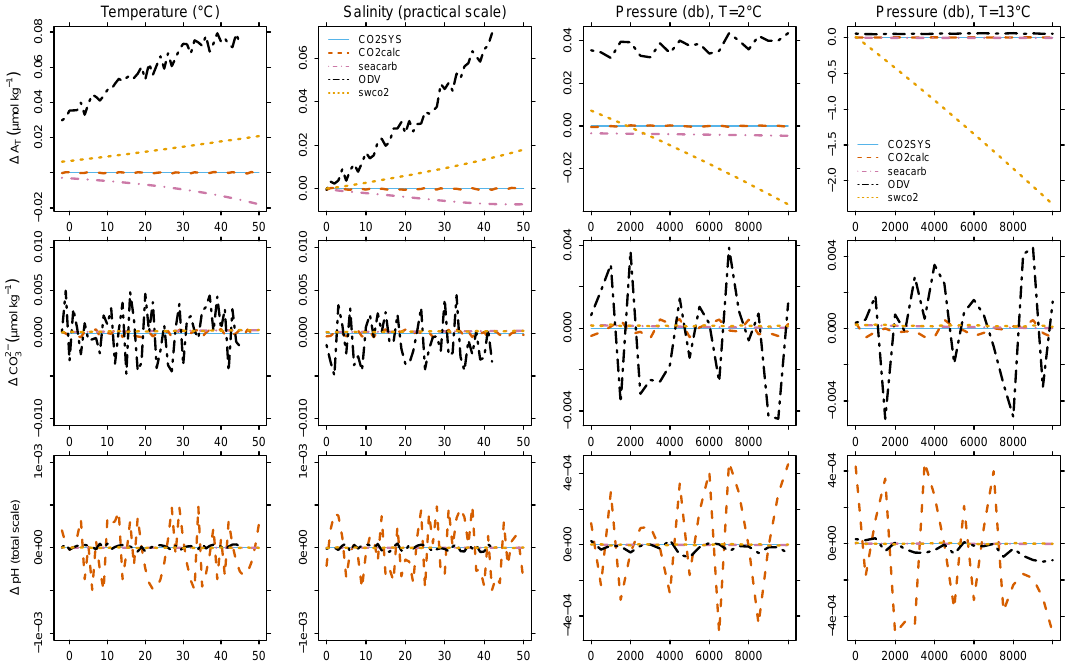
Figure 9. Variables computed from C T and p CO 2 with each package minus corresponding results from CO2SYS-MATLAB. Shown are computed A T (top), CO 2 − (middle), and pH (bottom) across ranges of T (column 1), S (column 2), and P when T = 2 ◦ C (column 3) and 3 when T = 13 ◦ C (column 4) for each